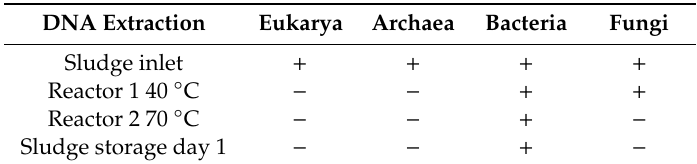
Table 2. Determination of species diversity associated with ATAD sludge at various stages of the ATAD process from sludge inlet of new sludge material through reactor 1 operating at 40 ◦ C, through reactor 2 operating at 70 ◦ C to treated sludge storage. DNA Extraction Eukarya Archaea Bacteria Fungi Sludge inlet + + + + Reactor 1 40 ◦ C